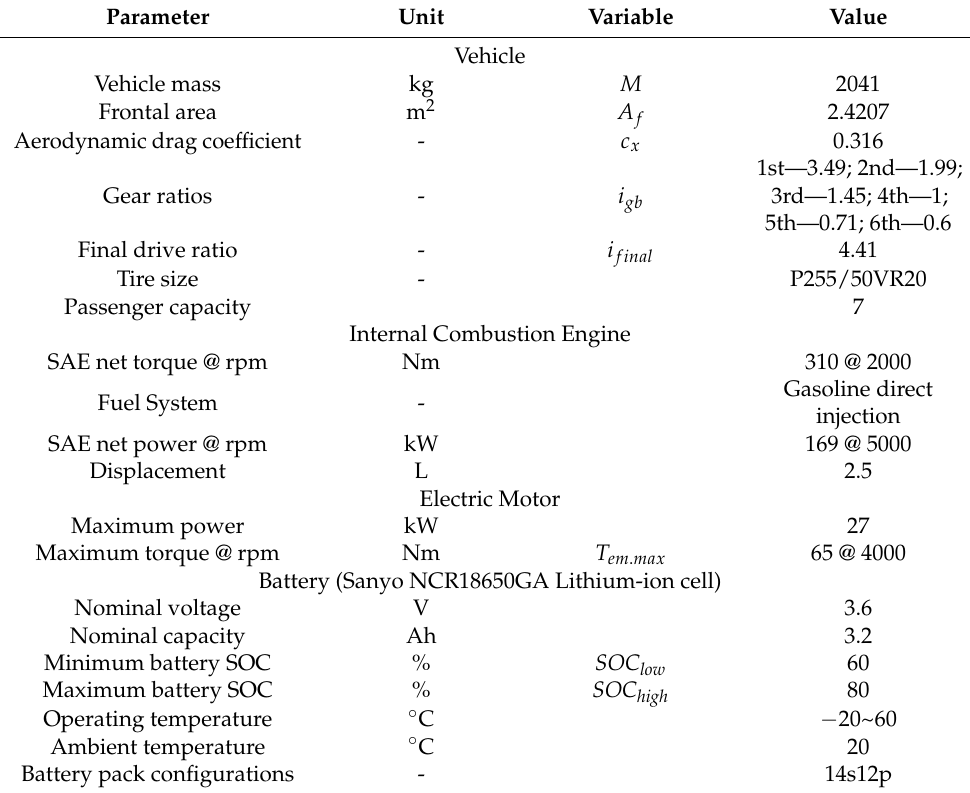
Table 1. Mazda CX9 2016